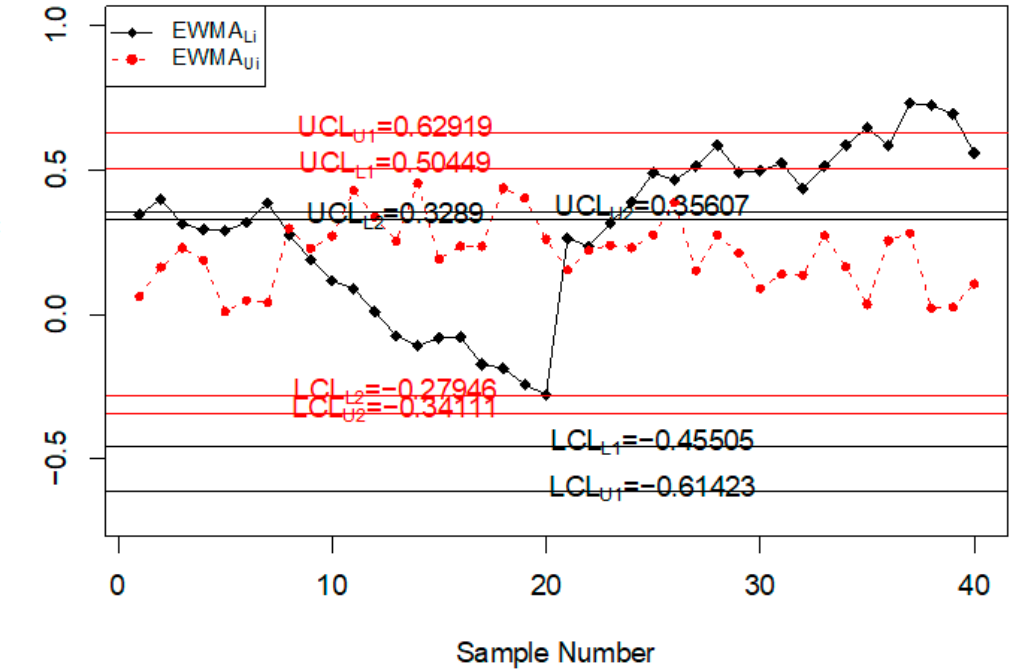
Figure 1. Proposed control chart for simulated data set.